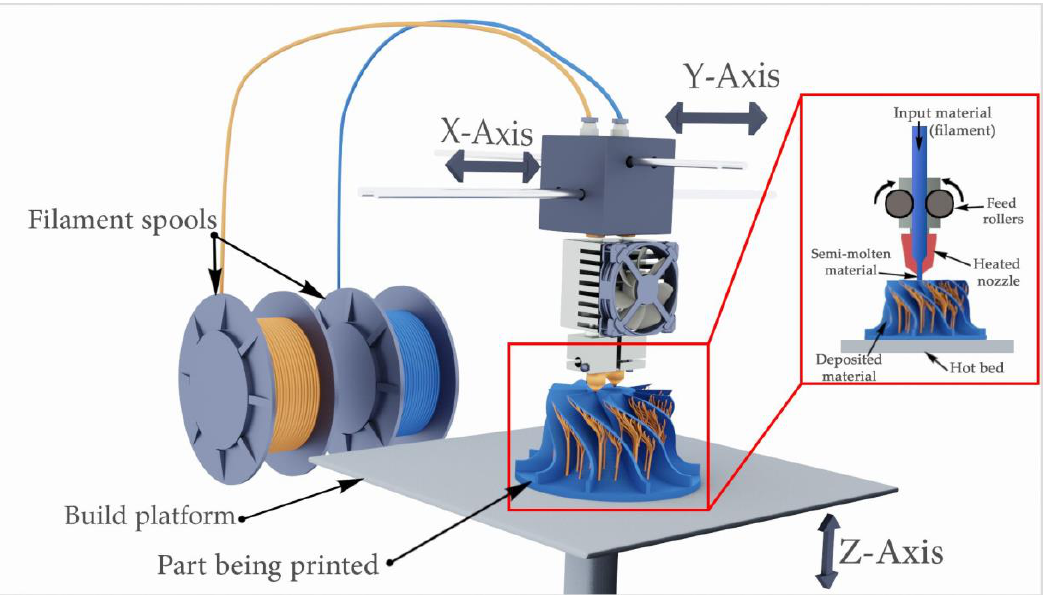
Figure 1. A schematic of the fused filament fabrication (FFF) process .